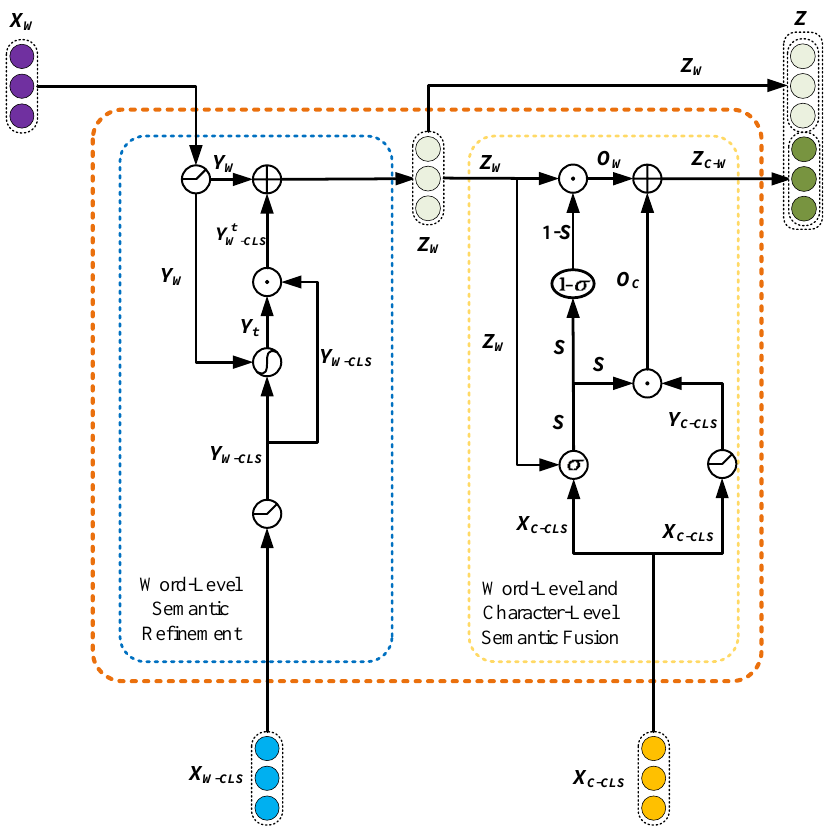
Figure 2. Multi-granularity feature interaction fusion mechanism diagram.